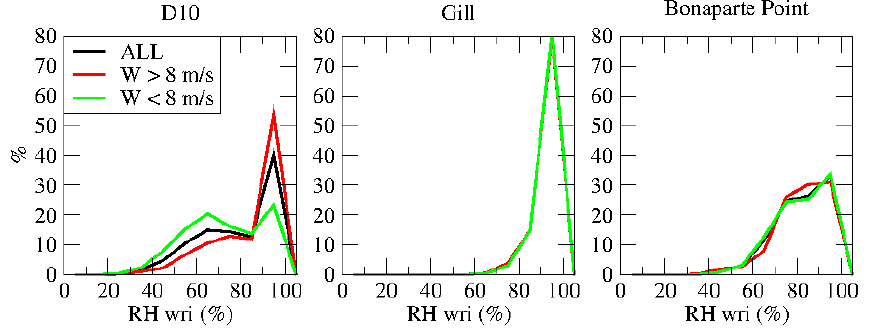
Figure 7. Same as Fig. 6 for three AMRC automatic weather stations. A lower wind threshold (8ms − 1 ) is used because the measurement height is less than